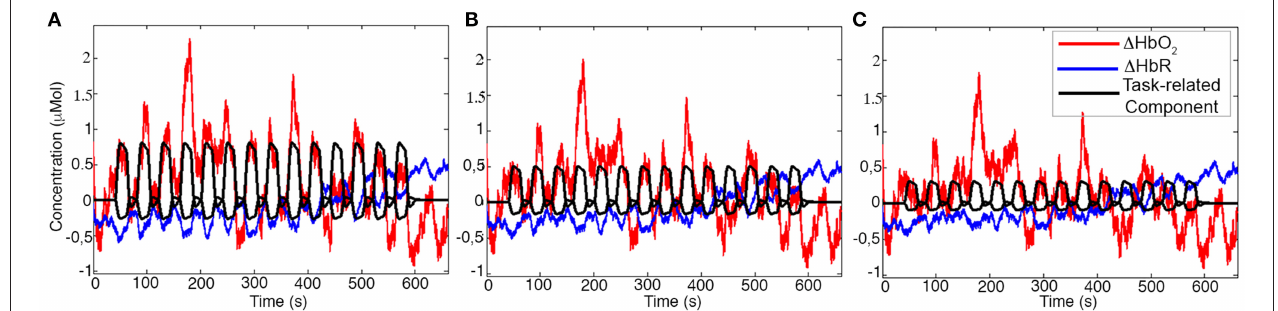
FIGURE 6 | Results of the filter stability for the BP BW filters (A) and LP BW filters (B) for all the combination of orders and F c . Green and red squares indicate stable and unstable filters, respectively. (C,D) show examples of filter stability analysis considering a BW BP filter with F c = [0.01 0.2] Hz. The filter results stable for a filter order 5 (C) , as the poles are inside the unitary circle as shown in the zoom. By contrast, with an order: 20 (D) the filter becomes unstable. Zeros are indicated by blue circles and poles by red crosses.